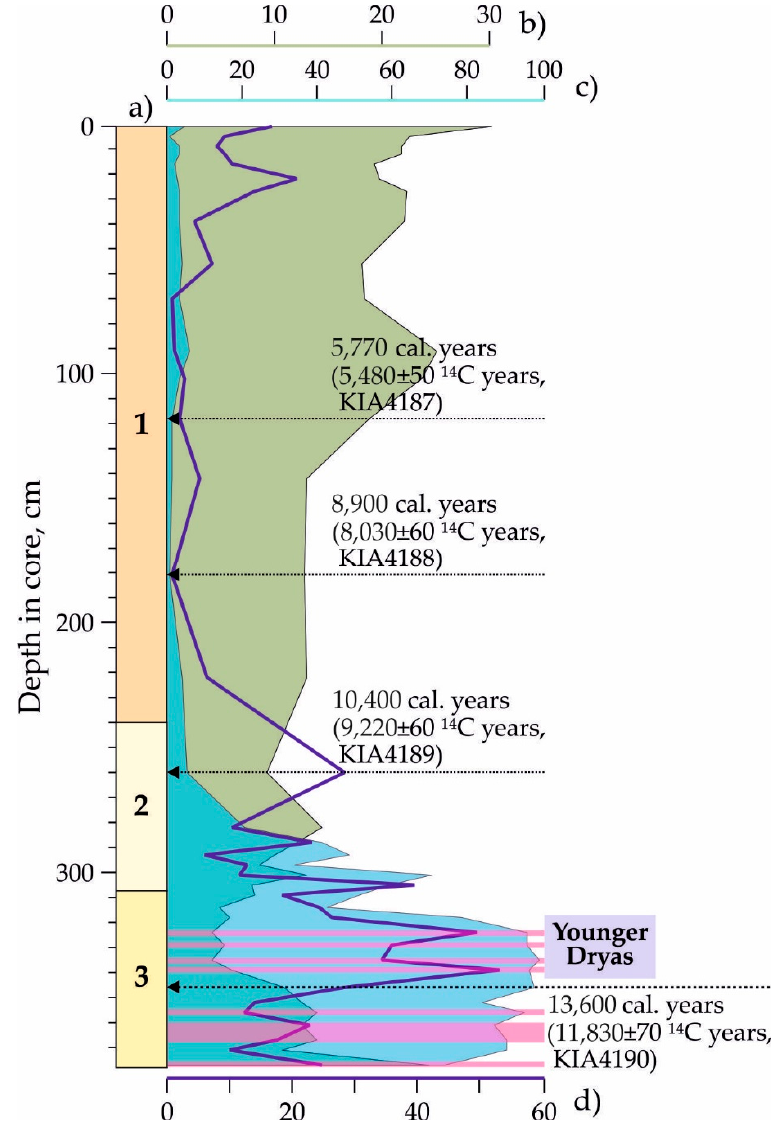
Figure 2. Lithostratigraphy of the AMK-340. Lithological description ( a ): number 1 is pelitic calcareous oozes with a CaCO 3 content of >40–50%, number 2 is pelitic weakly calcareous muds with a CaCO 3 content of 10–25%, and number 3 is silty-pelitic muds with a CaCO 3 content between 5.5% and 20% and an admixture of biogenic SiO 2 of up to 10–30% [12]. The green-colored graph ( b ) is a distribution of the radiolarian species Lithelius spiralis group as a marker of the temperate (non-glacial) conditions in the North Atlantic [13]. The blue-colored graph ( c ) is a distribution of the polar planktic foraminiferal species Neogloboquadrina pachyderma sinistral [13] as a glacial marker. The dark-blue line ( d ) is a distribution of the mineral grains in the sediment fraction of >100 μ m [13] as a marker of the ice-rafted material. Pink bars are the samples where the ash material was analyzed. Black dotted arrows with captions show positions of the AMS ( Accelerator Mass Spectrometry) 14 C -dates. Violet rectangle indicates the Younger Dryas unit.